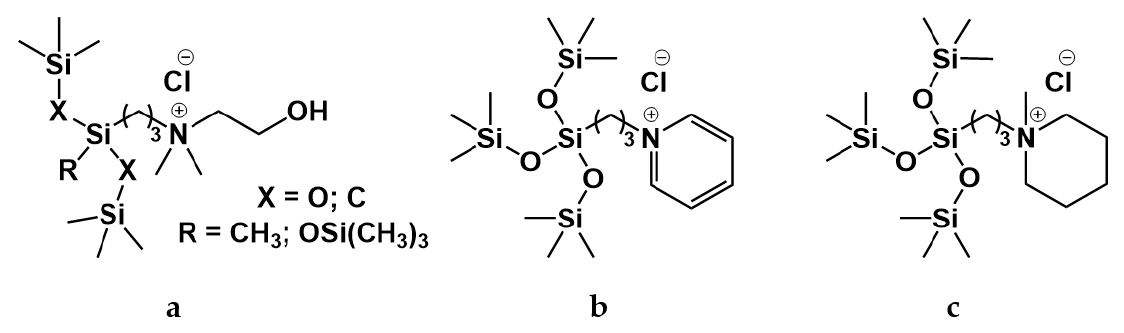
Figure 6. Chemical structures of cationic ammonium- ( a ), pyridine- ( b ) and piperidine-based ( c ) silicone surfactants.